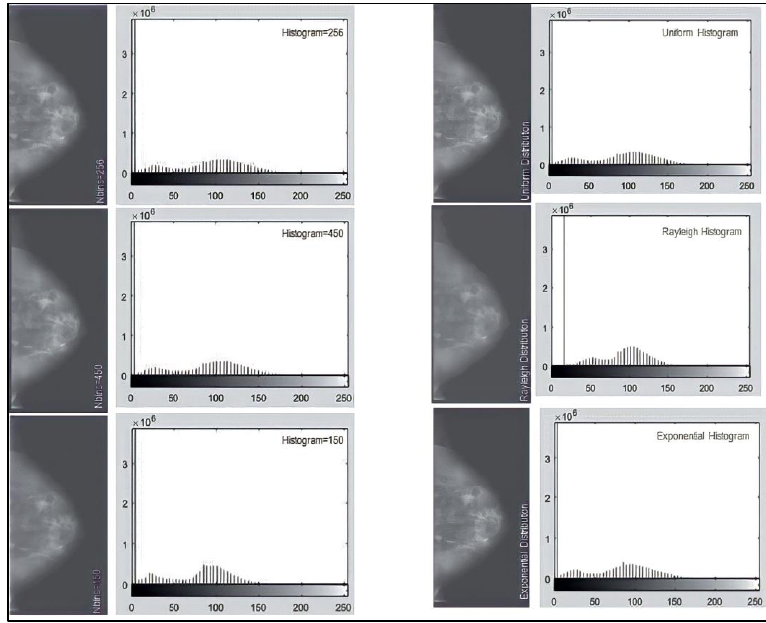
Figure 6. Distributions available in the CLAHE function and their histograms. From left to right uniform, Rayleigh, and exponential.